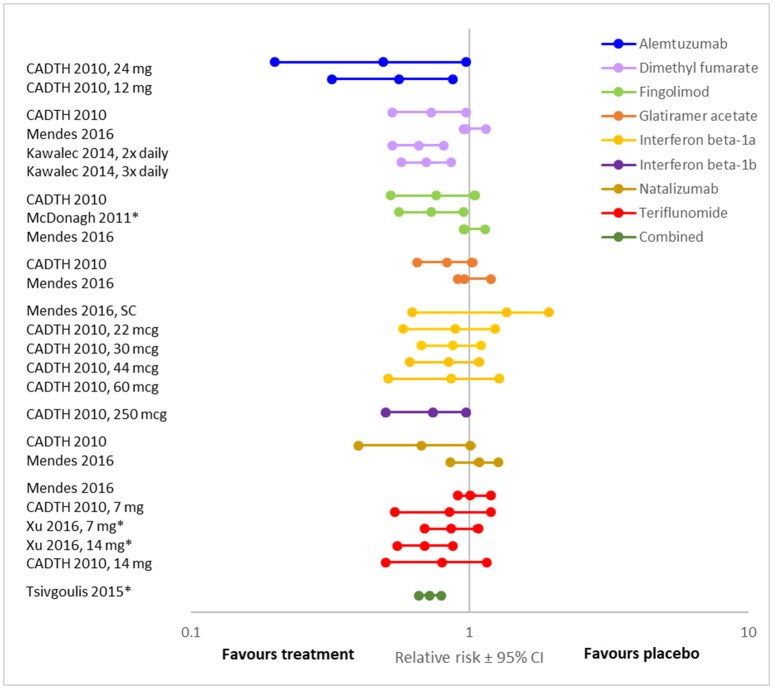
Relative risk of disease progression presented here for comparison (RR ± 95% CI after treatment with various DMT compared to placebo, values
 <1 indicate an effect). For each DMT, each line shows the results of a different meta-analysis/dosage combination. Source citation and dosages (if specified) are listed in the data label. These could not be consolidated due to overlap in included studies between meta-analyses. All meta-analyses included studies of people with relapsing MS. Combined indicates an aggregation of DMT, including dimethyl fumarate, fingolimod, glatiramer acetate, interferon beta-1a, interferon beta-1b, natalizumab, peg-interferon beta-1a, and teriflunomide. * Indicates that the analysis was a traditional meta-analysis, all others were network met-analyses.